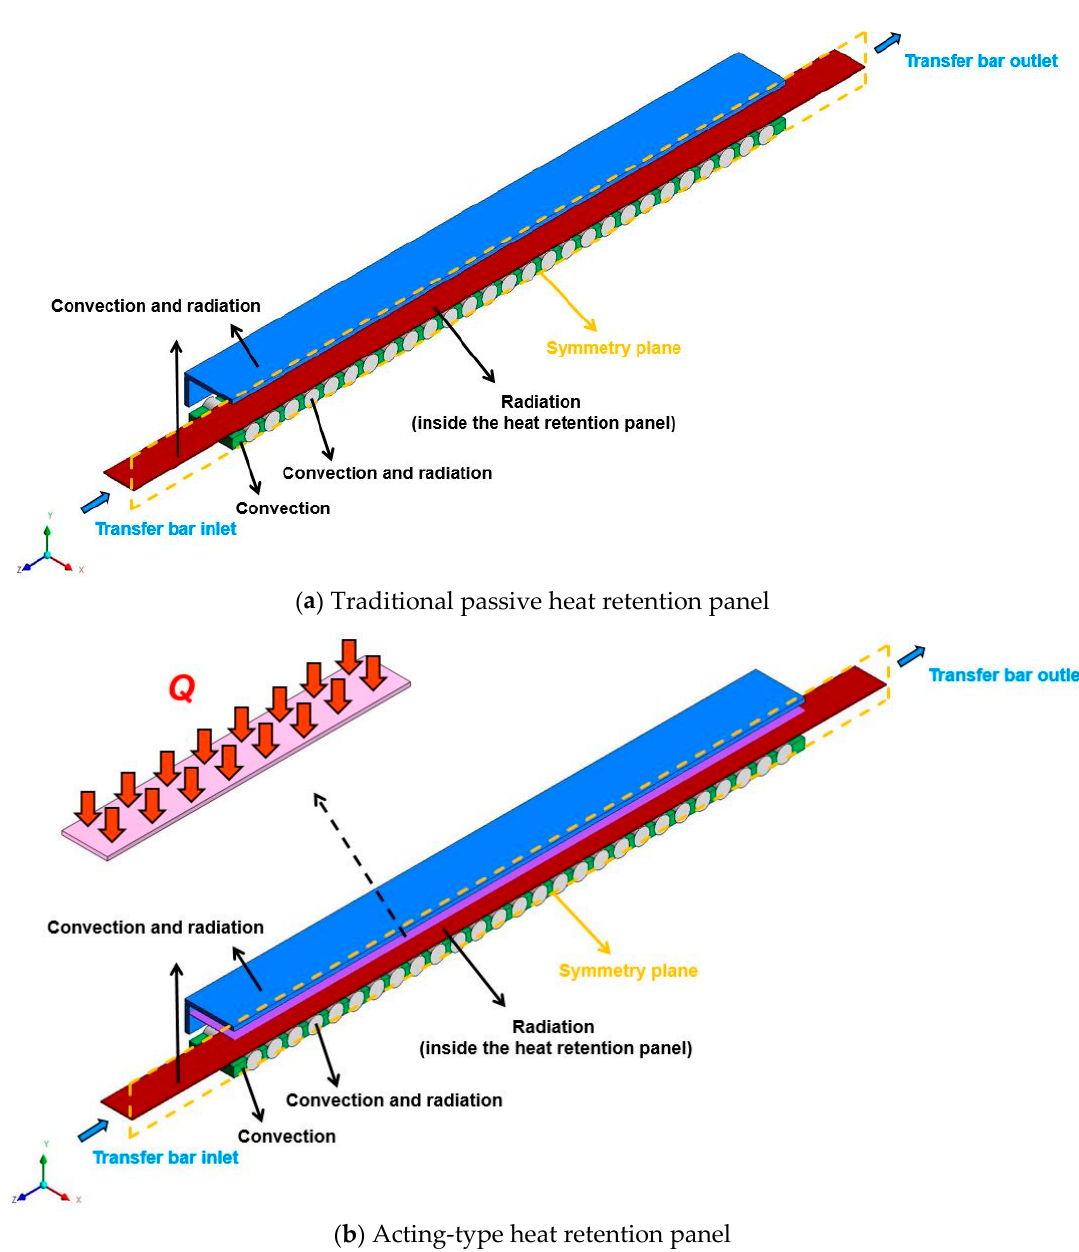
Figure 4. Boundary conditions of the numerical models.